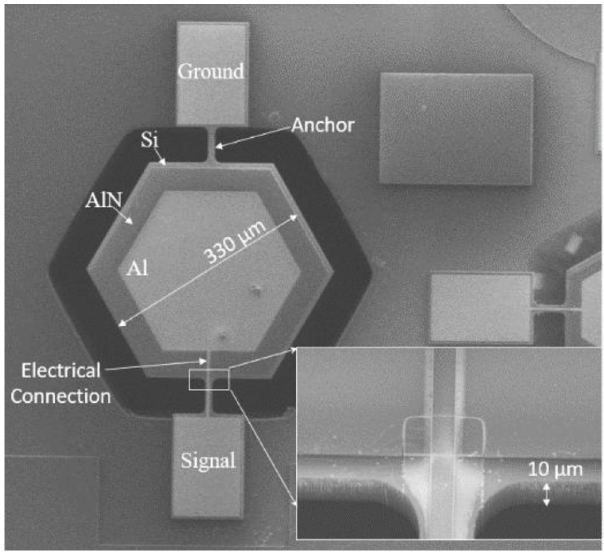
Figure 1. SEM of the piezoelectric resonator [12].